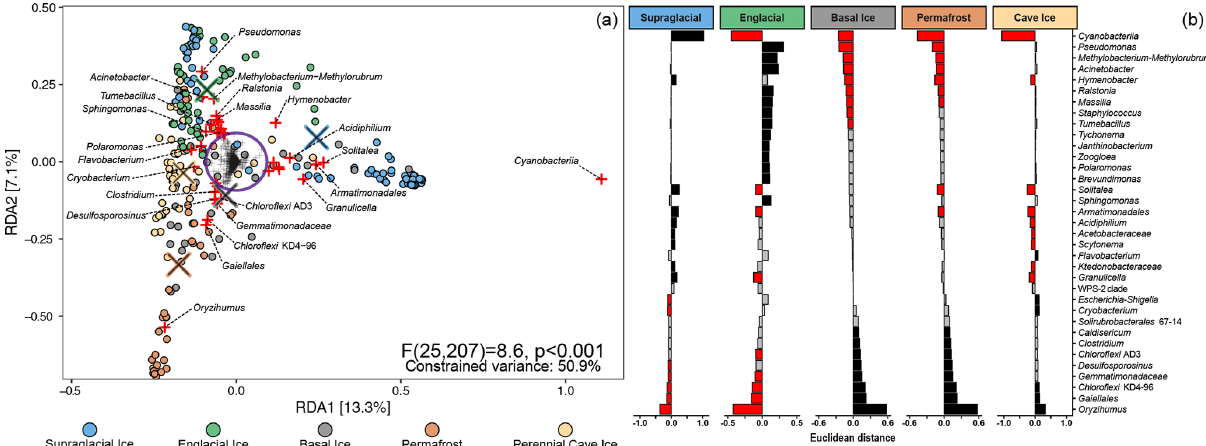
Figure 4. (a) RDA triplot of the distribution of 1745 microbial lineages across five different perennially frozen environments. Colored cir- cles represent individual samples. Centroids of each environment type are indicated with a “ × ” symbol. Plus signs ( + ) represent microbial lineages. The purple circle denotes the equilibrium contribution of the overall model and delineates lineages which substantially constrained the overall ordination. Those lineages are highlighted in red. (b) The magnitude of the scalar projections of these 41 lineages onto the cen- troids for each ice type approximates that lineage’s association with that frozen environment. Scalar projections smaller than the equilibrium contribution were considered inconclusive and marked gray. Positive and negative associations are black and red,